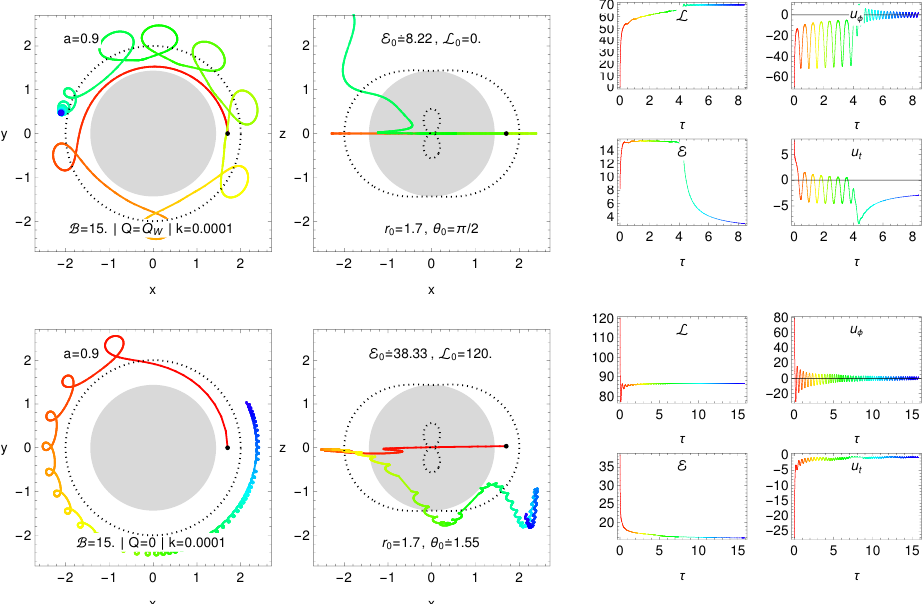
Figure 11. Comparison of the charged particle orbits in and outside ergosphere in the field of Kerr black holes having the Wald charge and without the